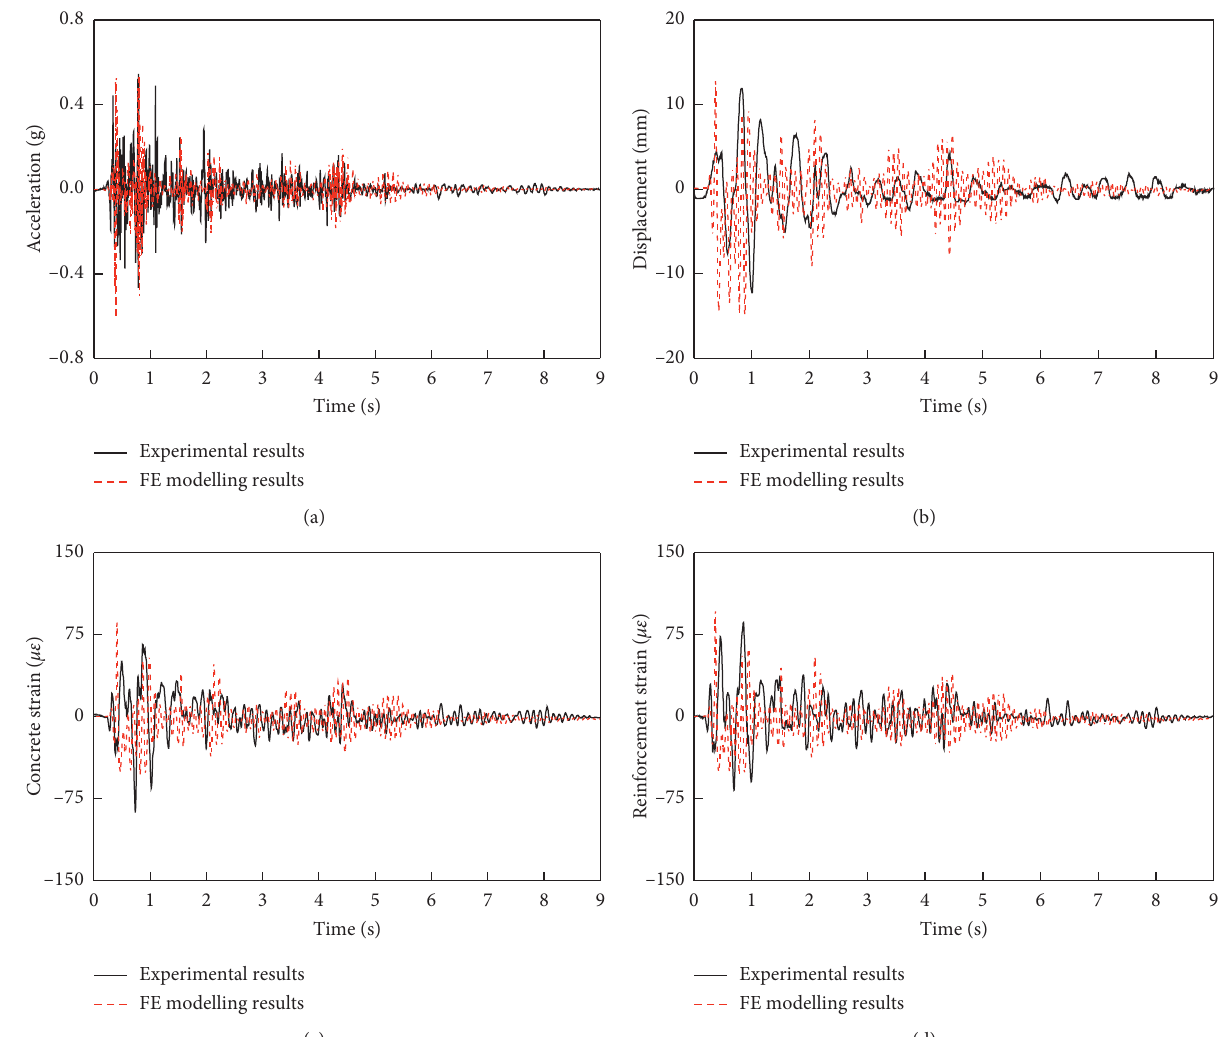
Figure 9: Comparison between testing and calculation results of Pier 1 for (a) acceleration, (b) displacement, (c) concrete strain, and (d) reinforcement strain. Table 3: Maximum absolute acceleration and displacement at each top of the pier for the experimental test and FE model. Comparison Pier number Test Calculation Error (%) Maximum acceleration (g)